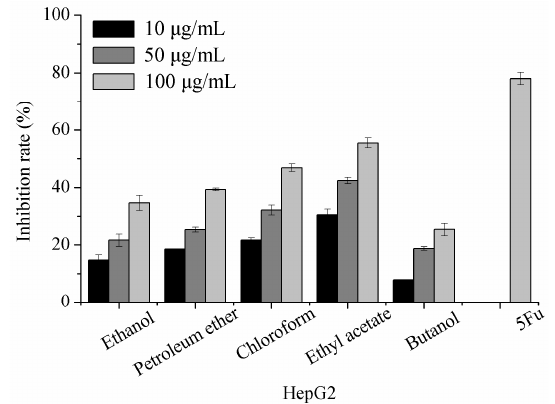
Figure 1. The effect of extracts from P. baumii mycelia on the proliferation of HepG2 tumor cells. Each value is expressed as means ± SD ( n = 3). 5-fluorouracil (5Fu) served as a positive control.